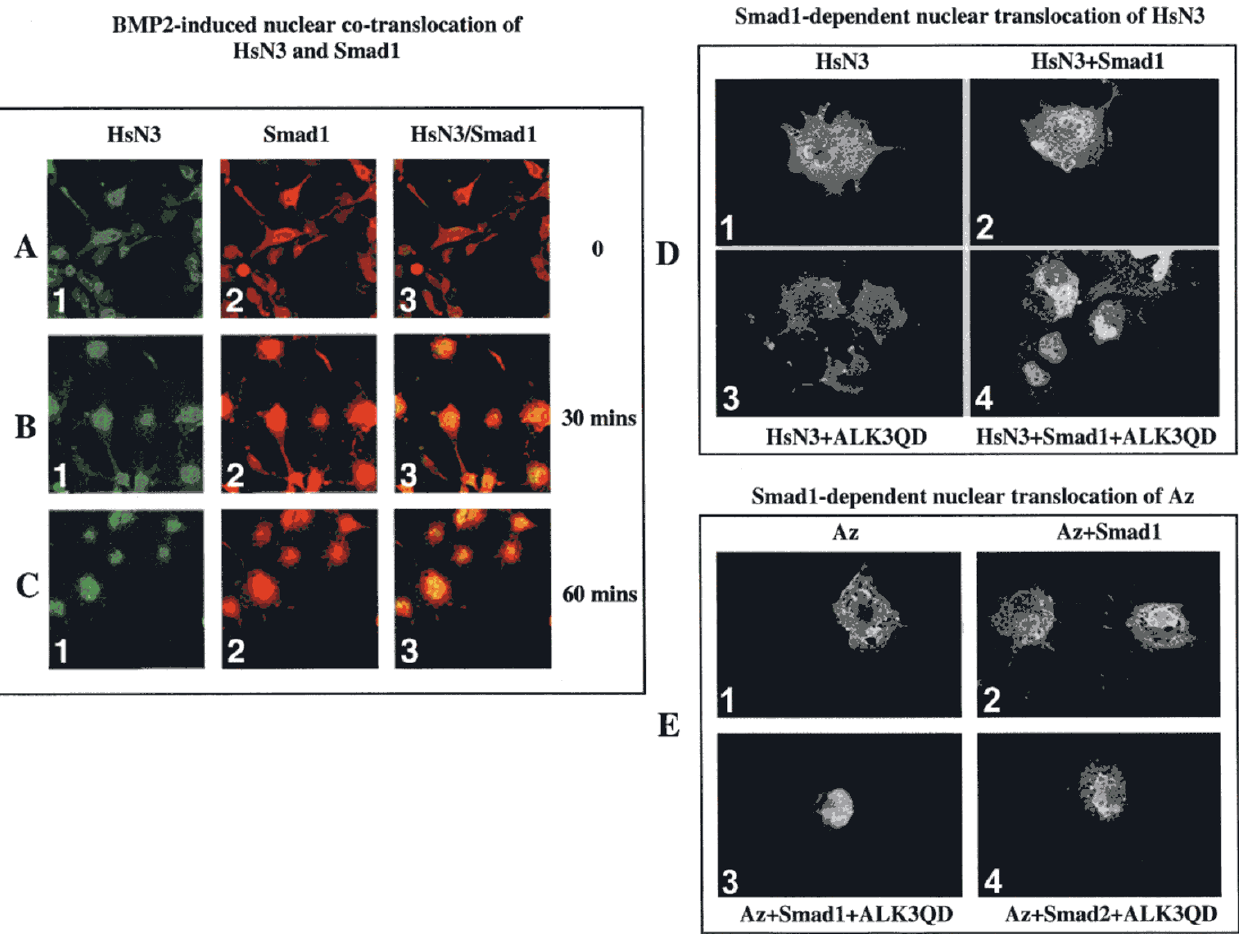
Figure 6 Smad1-dependent nuclear translocation of Smad1, HsN3 and Az in response to BMP type I receptor activa- tion.A-C. Smad1 and HsN3 are both rapidly translocated from the cytoplasm to the nucleus in response to BMP2. COS cells were transiently transfected with Smad1, ALK3 and BMPRII and were either not treated (A), or treated with BMP2 for 30 mins (B), and 60 mins (C). Smad1 (red) and HsN3 (green) signals at each time point were detected and their co-localization shown by overlaying HsN3 signals in panel "1" with Smad1 signals in panel "2" to yield panel "3". D. HsN3 nuclear translocation is dependent upon the coexpression of Smad1 and the activation of the BMP type I receptor. COS cells were transfected with the indicated plasmids. HsN3 was detected by anti-Flag monoclonal antibody and FITC conjugated anti-mouse secondary anti- body. E. Az is also translocated to the nucleus in response to the activation of BMP type I receptor in a Smad1-dependent fash- ion. COS cells were transfected with the indicated plasmids and stained with anti-Flag monoclonal antibody and FITC conjugated anti-mouse secondary antibody. To maximize the details of intracellular localization of each protein, each panel only shows the single cell-image that represents the localization patterns in more than 80% transfected